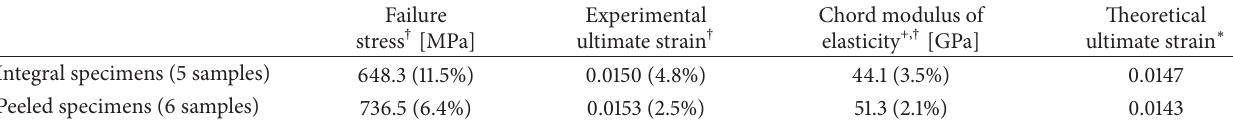
Table 1: Summary of the results of tensile failure tests on GFRP specimens.